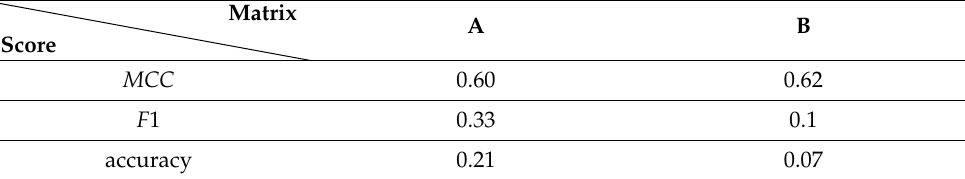
Table 6. Comparison of the performance metrics for matrices A and B.